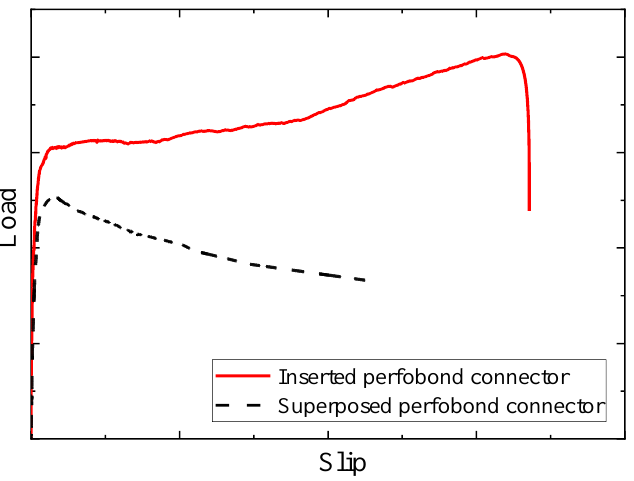
Figure 2. Typical load – slip curves of two connector types.